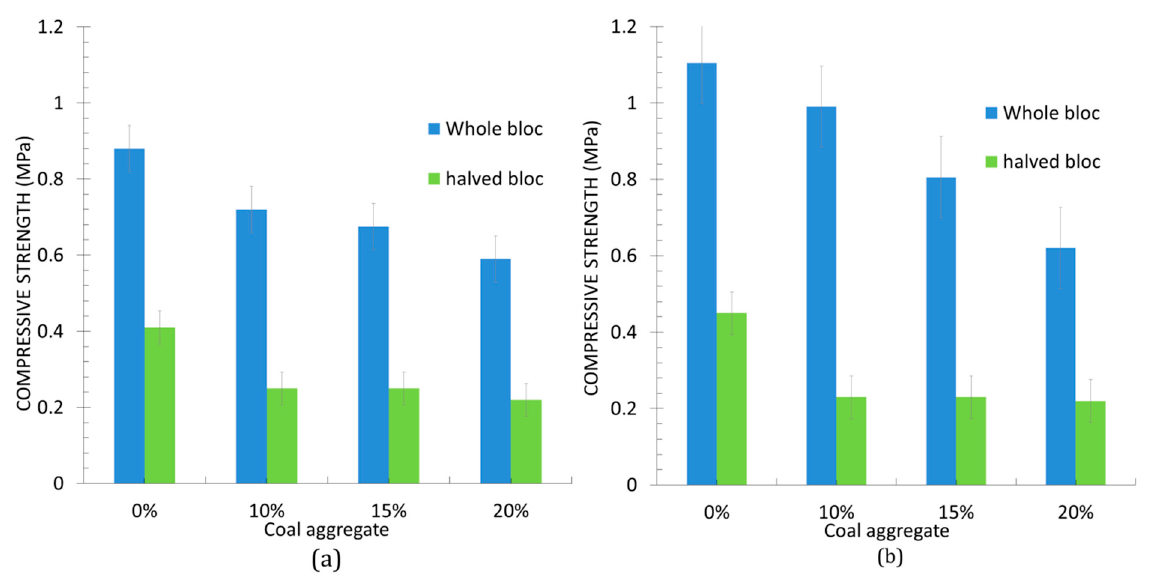
Figure 10. Compressive strength of brick samples vs coal aggregates: ( a ) without lime, ( b ) with 4% of lime.